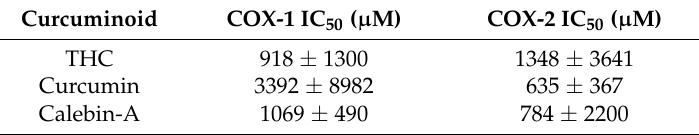
Figure 5. The anti-inflammatory and antioxidant activity of THC and other curcuminoids. The direct effects of curcuminoids on inhibition of cyclooxygenase displayed as the COX-2 to COX-1 IC 50 ratio ( A ); the inhibition of lipoxygenase by THC and other curcuminoids displayed as lipoxygenase activity in mmol/min/mL at the listed concentrations of curcuminoids ( B ); the antioxidant activity of THC and other curcuminoids as measured by the antioxidant assay kit (Cayman) ( C ); displayed are the TNF- α concentrations produced by the curcuminoids as a measure of inflammatory activity in pg/mL ( D ). Using a one-way ANOVA, the results for 50 and 100 µ M levels are statistically significant p < 0.001. All values represent a mean of 3 with standard deviation. Table 1. The potency of curcuminoids against cyclooxygenases.